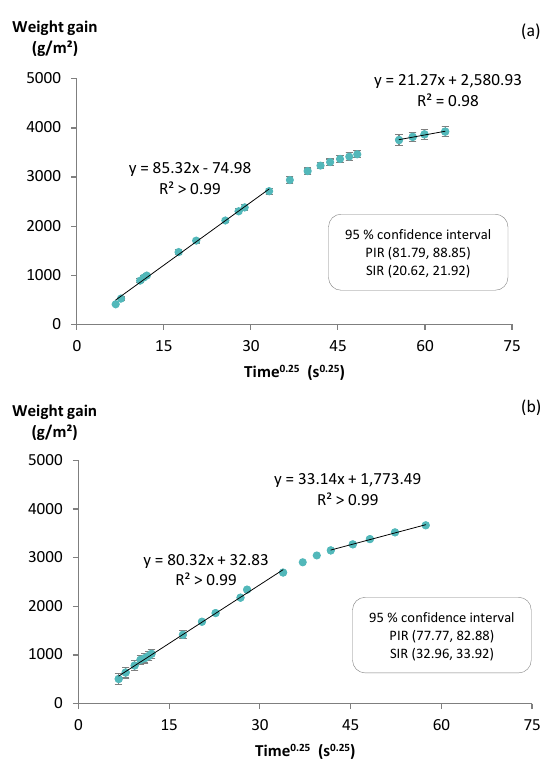
Figure 4. Capillary imbibition rate of Mix 3 at 28 (a) and 91 (b) days of age. The 95 % confidence intervals of the corresponding PIR and the SIR are given between parenthesis.